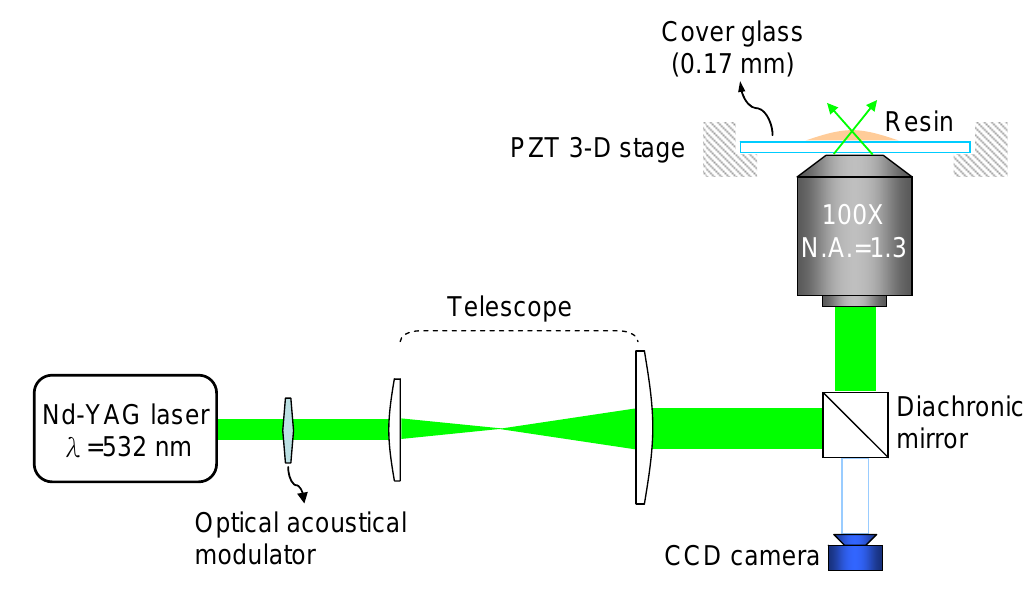
Figure 1. The two-photo polymerization 3-D microfabrication system.